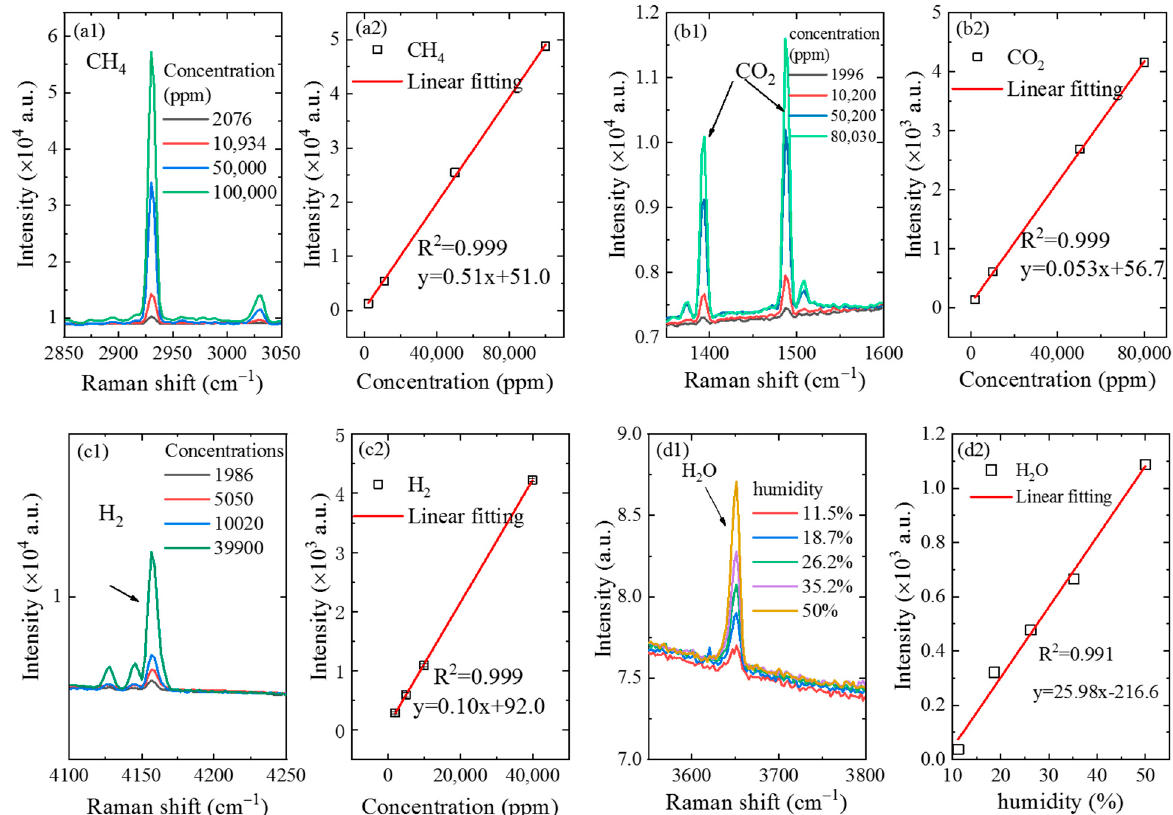
Figure 4. Raman spectra and calibration curve of gas samples in different concentrations obtained by the CERS probe. ( a1 ) Raman spectra of CH 4 ; ( a2 ) calibration curve of CH 4 based on the peak intensity with Raman shift of 2917 cm − 1 ; ( b1 ) Raman spectra of H 2 ; ( b2 ) calibration curve of H 2 based on the peak intensity with Raman shift of 4156 cm − 1 ; ( c1 ) Raman spectra of CO 2 ; ( c2 ) calibration curve of CO 2 based on the peak intensity with Raman shift of 1387 cm − 1 ; ( d1 ) Raman spectra of water vapor; ( d2 ) calibration curve of H 2 O based on the peak intensity with Raman shift of 3650 cm − 1 .